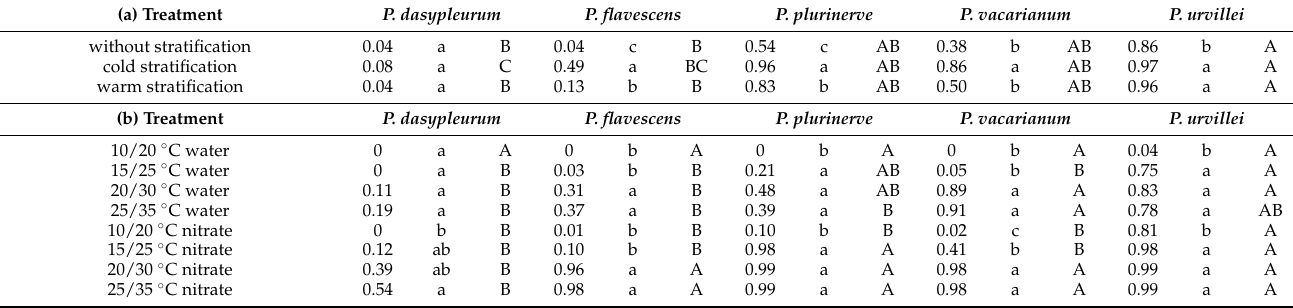
( a ) Lowercase letters indicate differences among stratification treatments within each species. Uppercase letters indicate differences among species within each stratification treatment ( p < 0.05). ( b ) Lowercase letters indicate differences among temperature regimes within each species and nitrate addition combination. Uppercase letters indicate differences among species within each temperature regime and nitrate addition combination. Bold numbers indicate differences between distilled water and nitrate addition within each temperature regime and species combinations ( p <